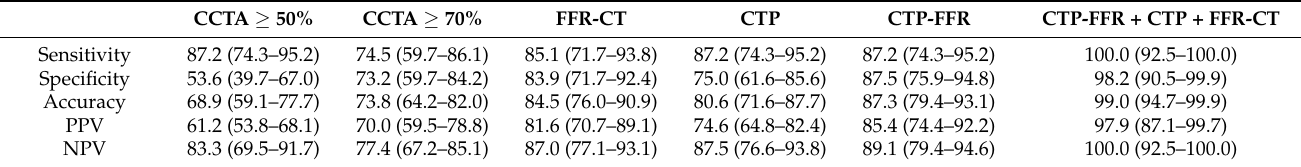
Figure 3. Graph showing diagnostic performance of CTP-FFR, CTP, FFR-CT and CCTA. AUC of receiver operating characteristics curve analysis is shown on per vessel for CTP-FFR, CTP, FFR-CT and visual stenosis grading (stenosis ≥ 50%) at CCTA. The dotted line represents the reference line. AUC = area under receiver operating characteristics curve. Other abbreviations same as in Figure 1. Table 2. Diagnostic performance of CCTA and CTP-FFR on a per-vessel